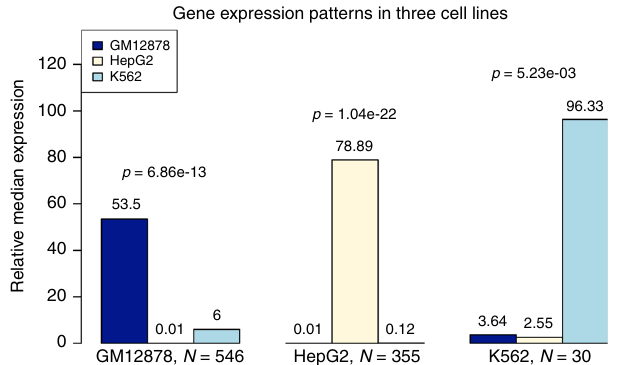
Fig. 4 Gene expression patterns for genes with cell-line-speci fi c functional variants in promoters. Each bar presents the median expression in one cell line for genes with cell-line-speci fi c functional variants in promoters relative to the median expression for these genes in the other two cell lines combined. The p -values are calculated by testing whether the expression in the matched cell line is greater than the other two cell lines combined, using the Wilcoxon rank sum test. The GenoNet threshold to de fi ne functional/non-functional variants in promoter region of a gene is